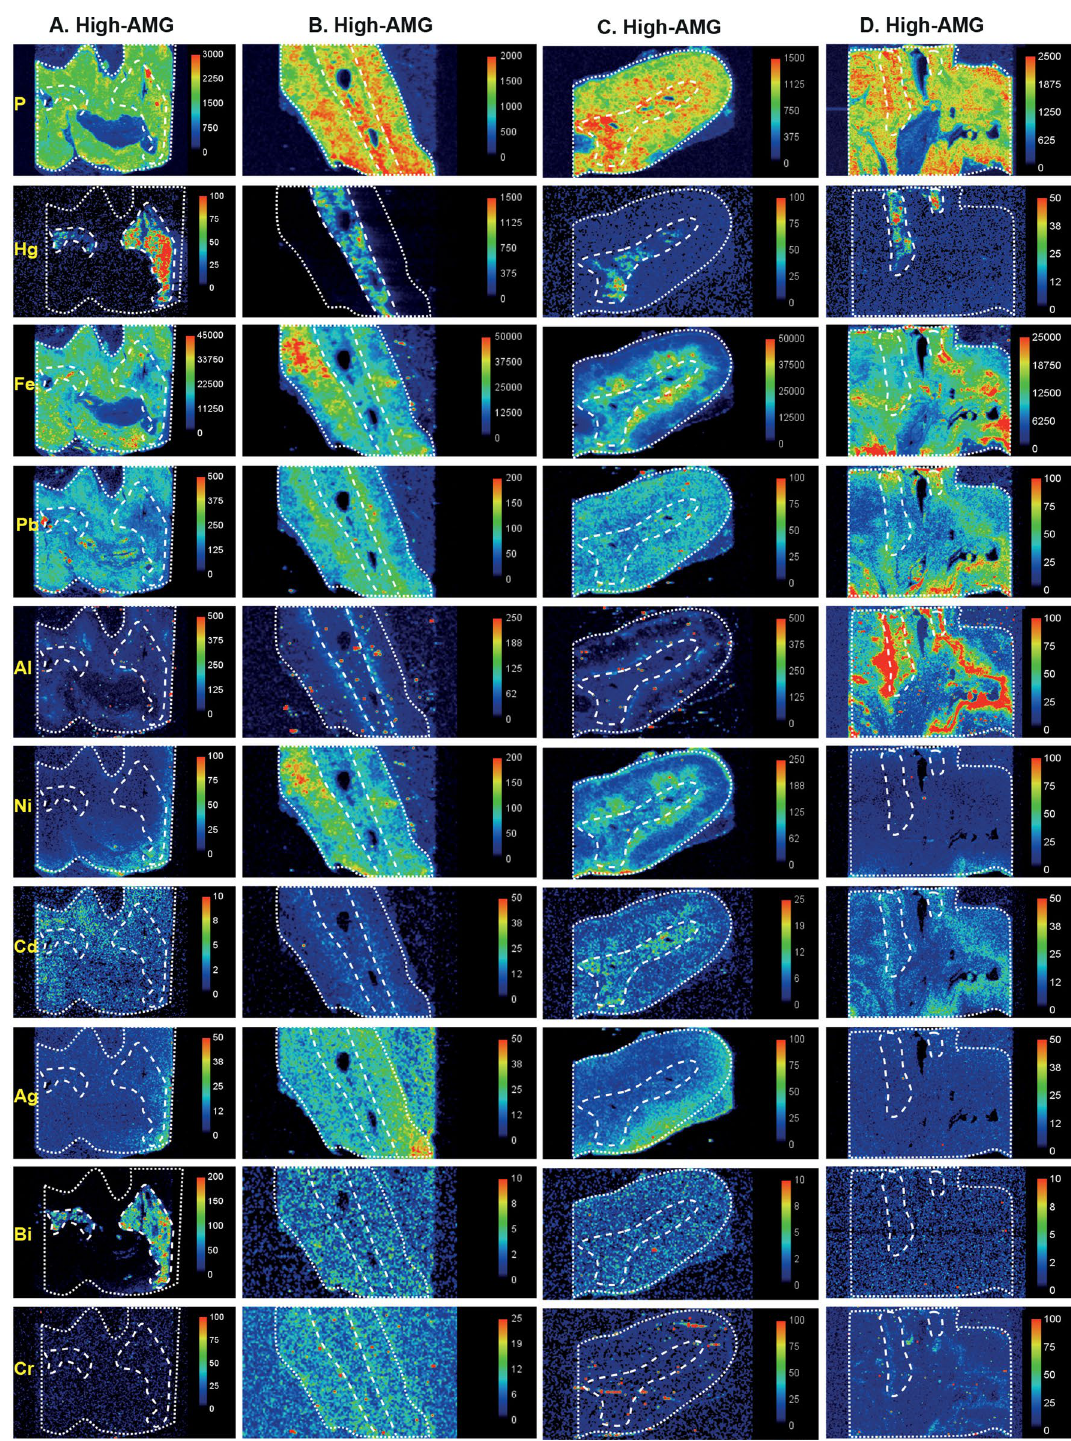
Figure 6. LA-ICP-MS I. The dotted lines outline the adrenal gland in the section, the medulla is outlined by the internal dashed lines, and the cortex occupies the space between the dashed and dotted lines. Phosphorus LA-ICP-MS indicates the degree of cellularity. Mercury is seen selectively in the medulla of all four samples ( A – D ) that had high-AMG. Metals present in both cortex and medulla are iron ( A – D ), lead ( A – D ), cadmium ( A , C , D ), bismuth ( B , C ), nickel ( B , C ), silver ( B ) and aluminium (in the cortical zona reticularis) in ( D ). Bismuth is present in the medulla in ( A ) and silver in the cortex in ( C ). Scale = counts per second (proportional to